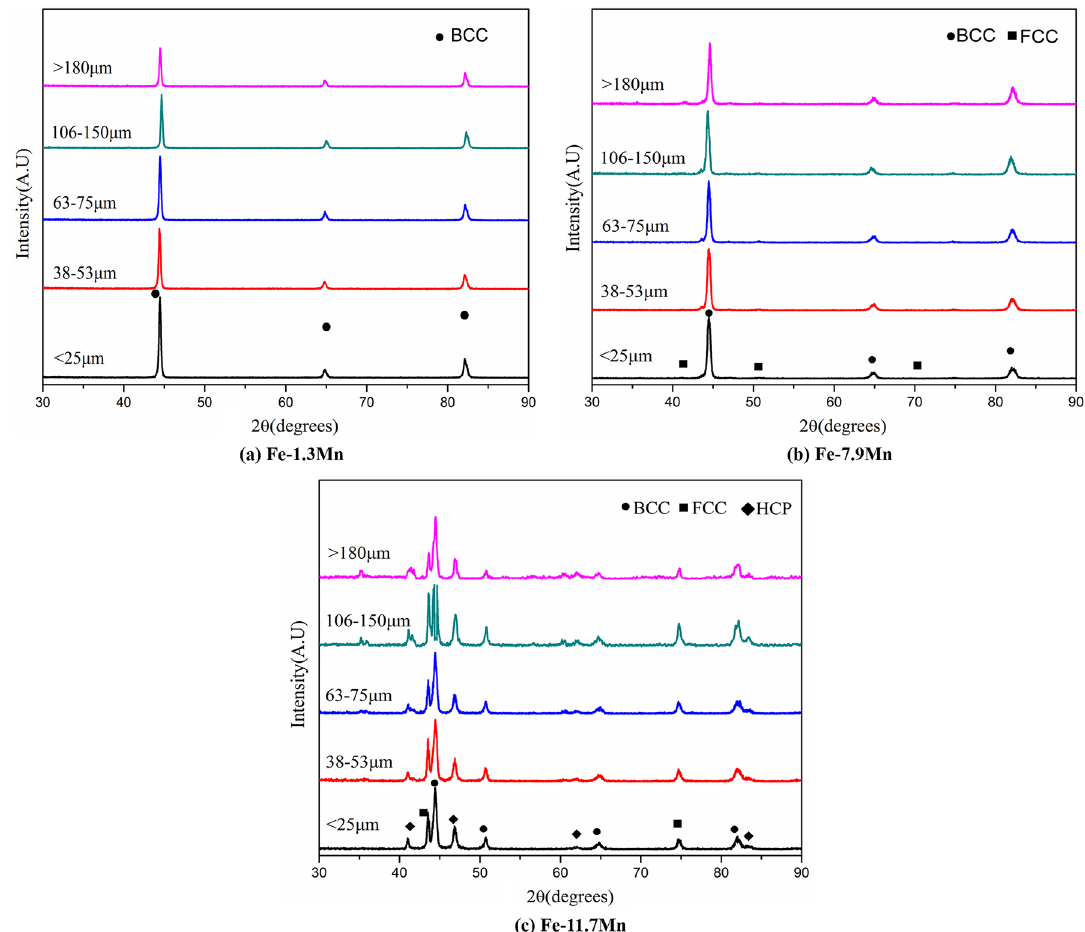
Figure 2. XRD of Fe-1.3, 7.9, 11.7Mn alloy atomized powders. (a) Fe-1.3Mn; (b) Fe-7.9Mn; (c) Fe-11.7Mn.